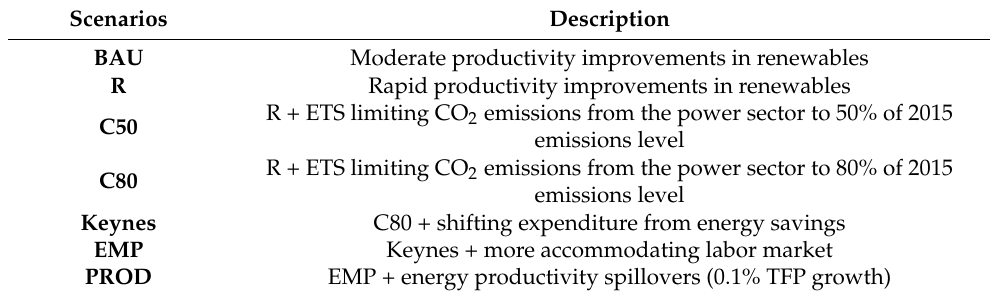
Table 2. Scenarios